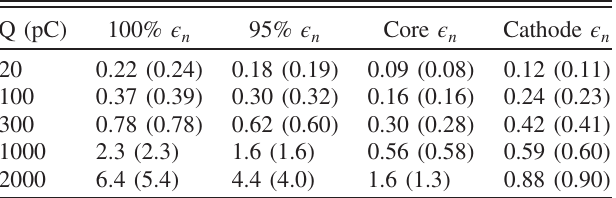
TABLE III. Measured horizontal (vertical) normalized emit- tances ( μ